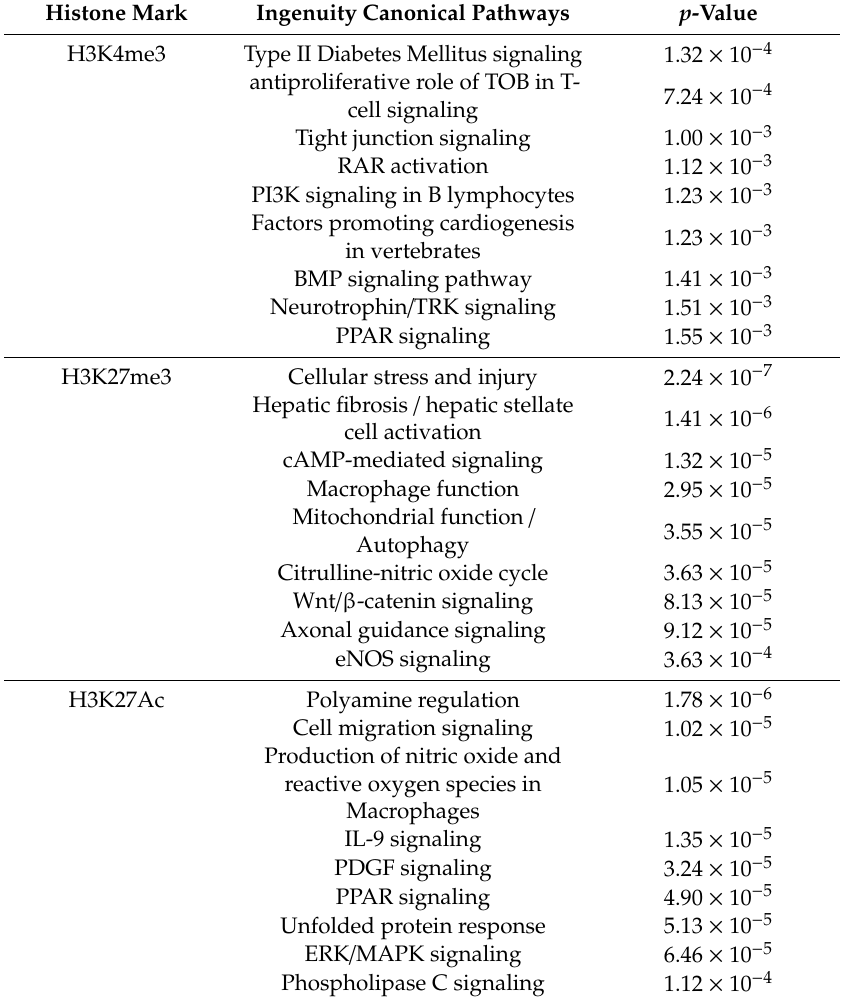
Table 4. Top IPA pathways potentially regulated by histone modifications and disrupted in 10-wk IUGR